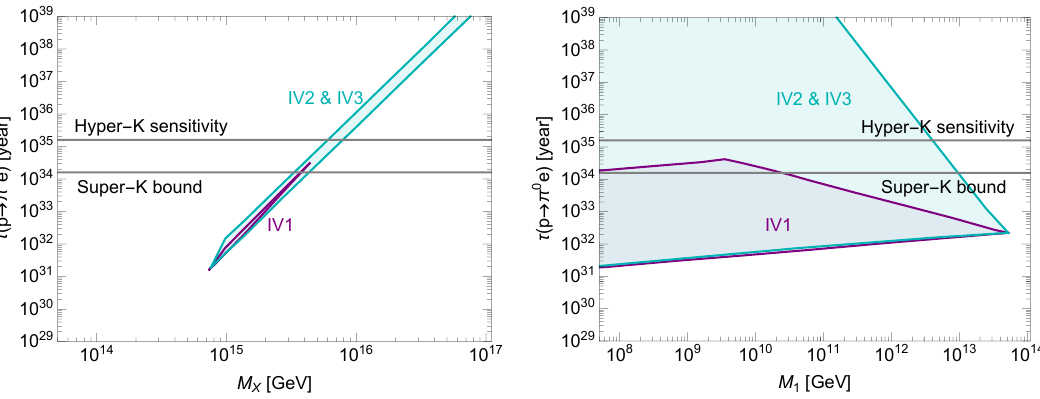
Figure 6 . Predictions of the proton decay lifetime as a function of the GUT scale, M X , and intermediate scale, M , in breaking chains IV1-3. The colour for each chain is specified in both the 1 upper and low